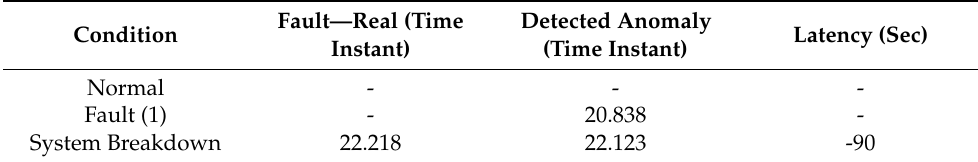
Table 5. Results of fault detection.